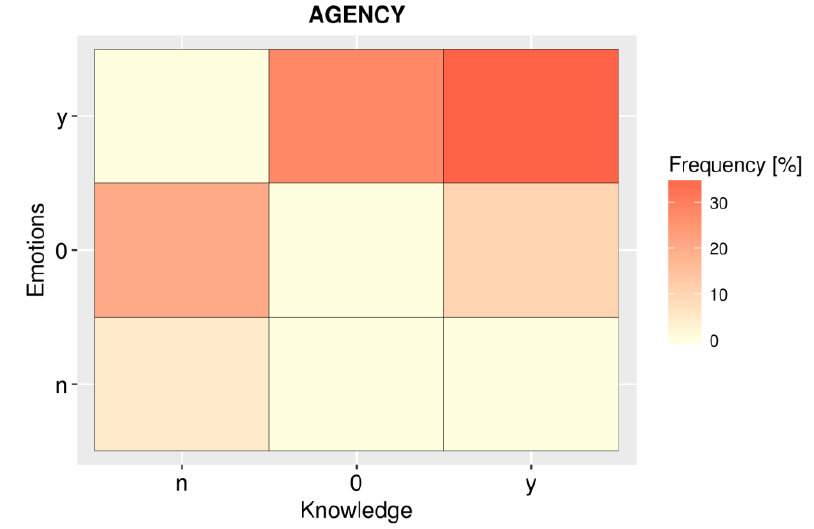
Figure 9. Frequency of responses compared between the knowledge and emotions dimensions—agency theme.